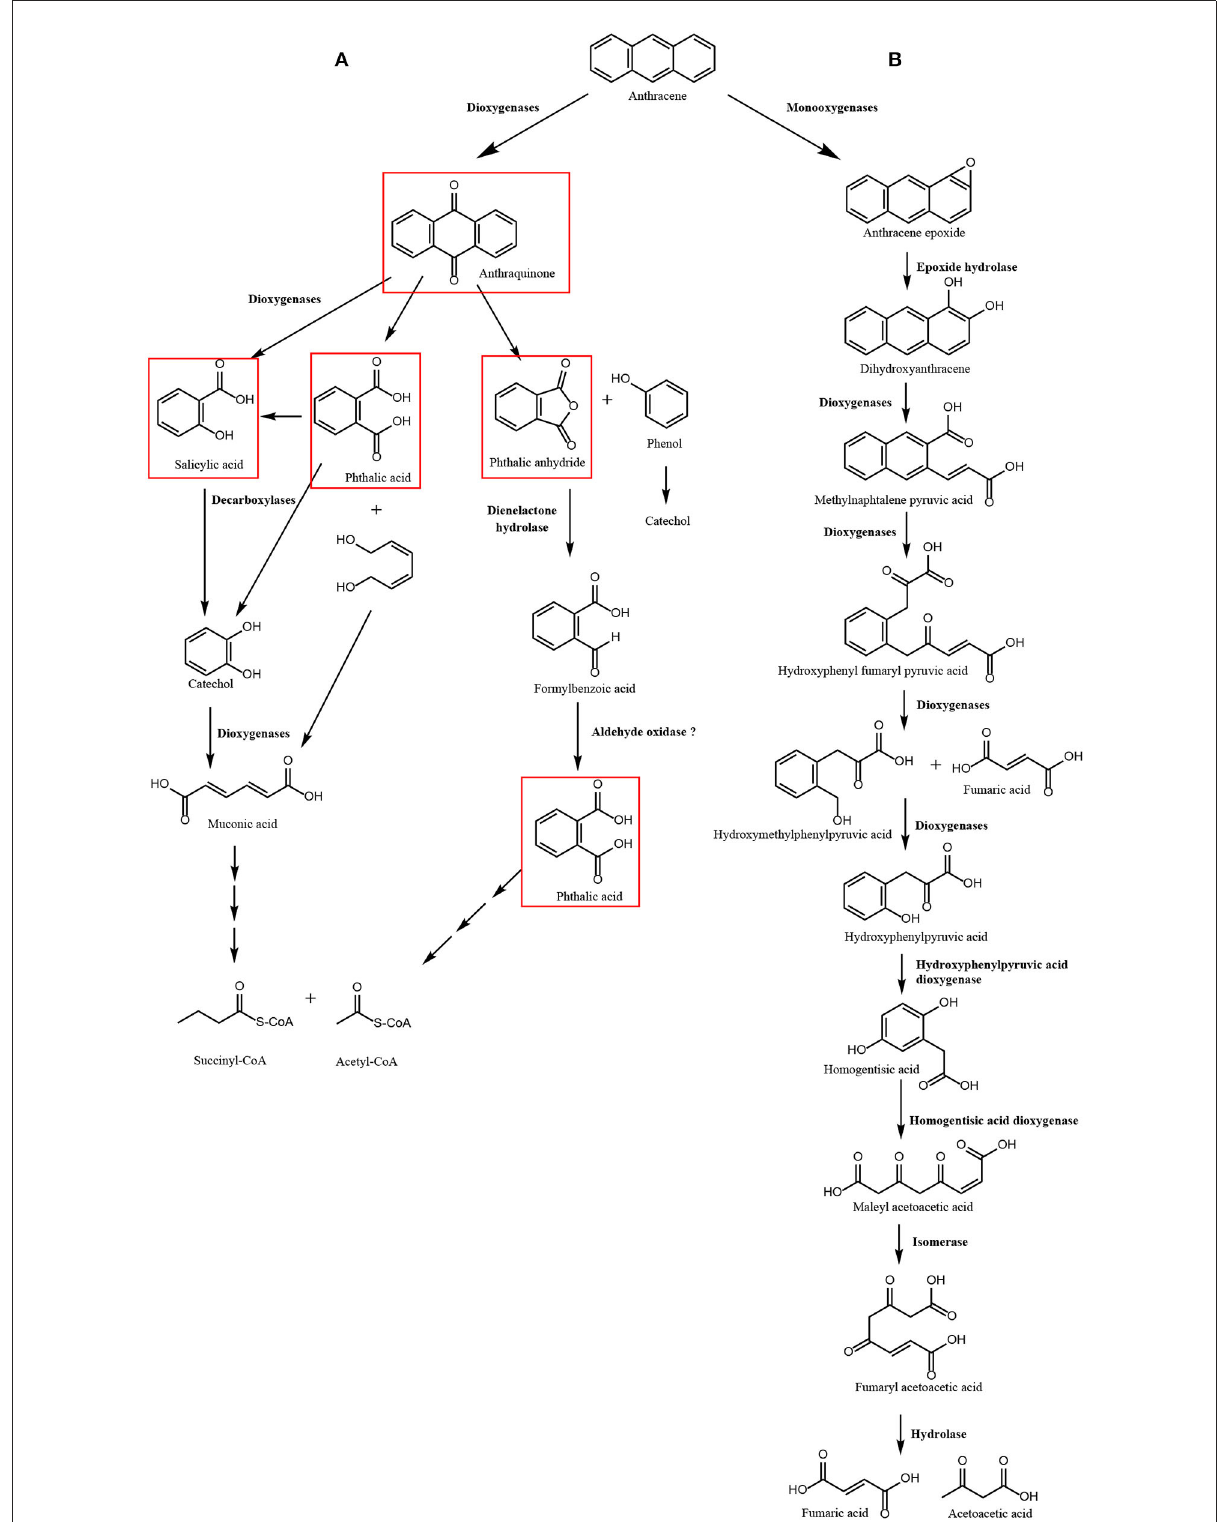
FIGURE1 Scheme of pathways of anthracene (ANT) degradation in Ulva lactuca . Pathway 1 involves 2-oxoglutarate Fe (II) dioxygenases, aromatic ring dioxygenase and dienelactone hydrolase producing anthraquinone, phthalic anhydride, salicylic acid, and phthalic acid as ANT metabolites (A) . Pathway 2 that involves monooxygenases, epoxide hydrolase, 2-oxoglutarate dioxygenases, hydroxyphenylpyruvic dioxygenases, and homogentisic acid dioxygenases producing 1,2-dihydroxyanthracene, hydroxyphenylpyruvic acid, and homogentisic acid as ANT metabolites (B) . Metabolites detected by GC–MS analyses are framed in